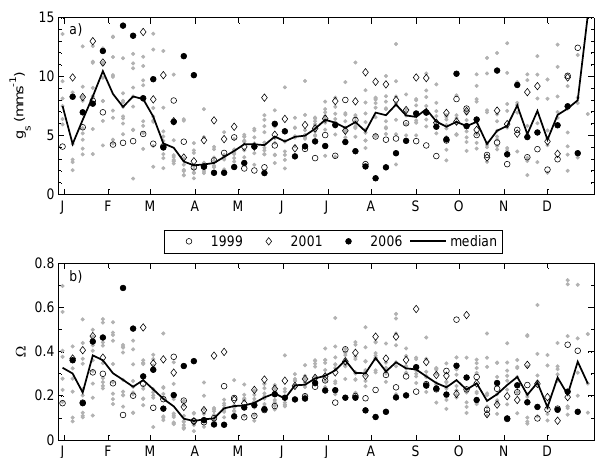
Fig. 7. Seasonal and inter-annual variability of (a) surface conduc- tance ( g s , mms − 1 ) and (b) de-coupling coefficient ( (cid:127) ). The points represent weekly averages on daytime (08:00–20:00) and the solid line the weekly median over 1997–2008. Wet canopy conditions are